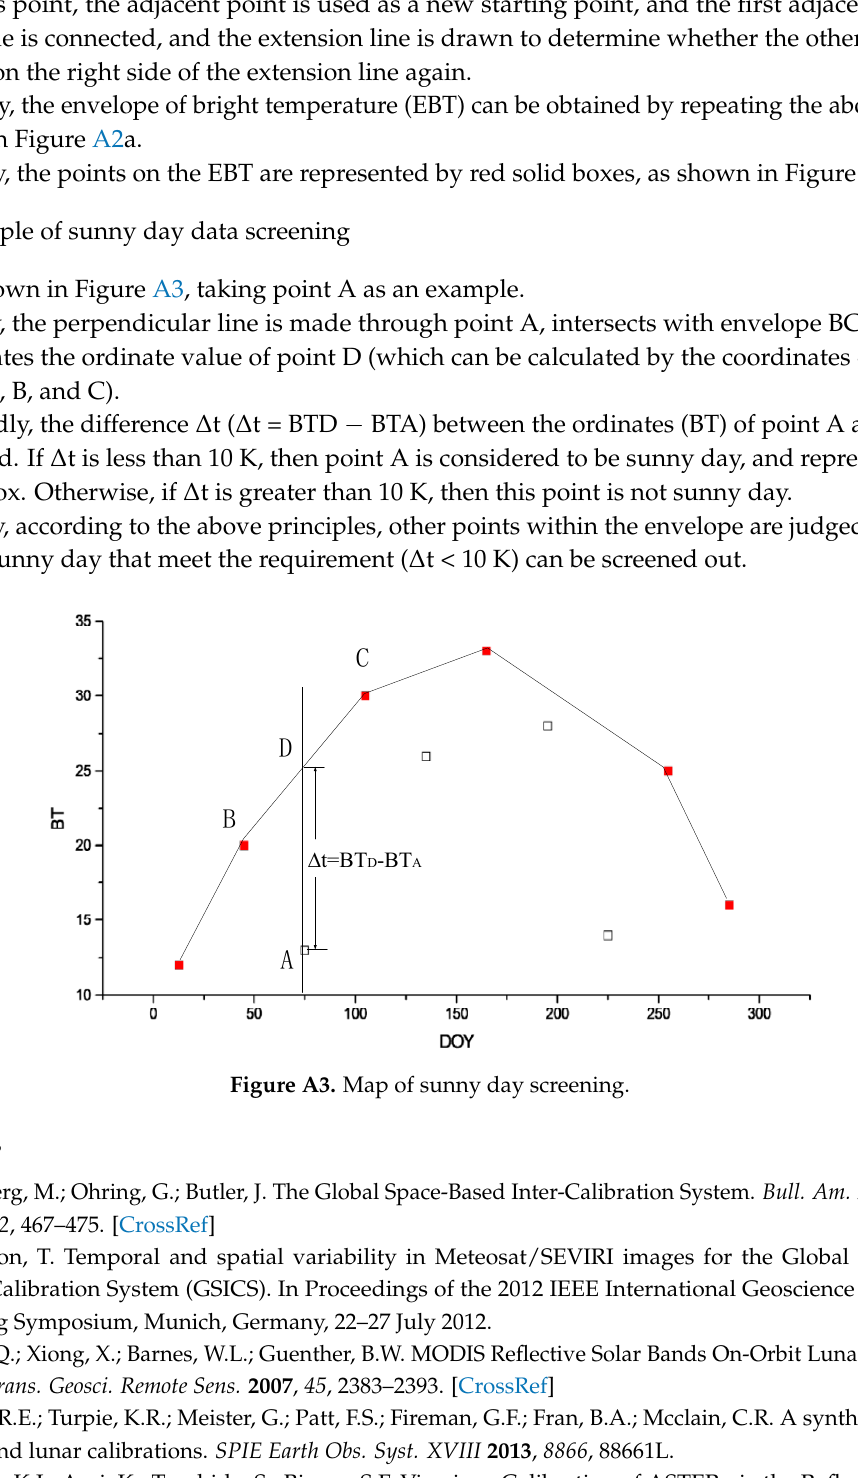
Figure A2. Calculation process of envelope of bright temperature (EBT). ( a )Process of EBT calculation; ( b )Results of EBT calculation.